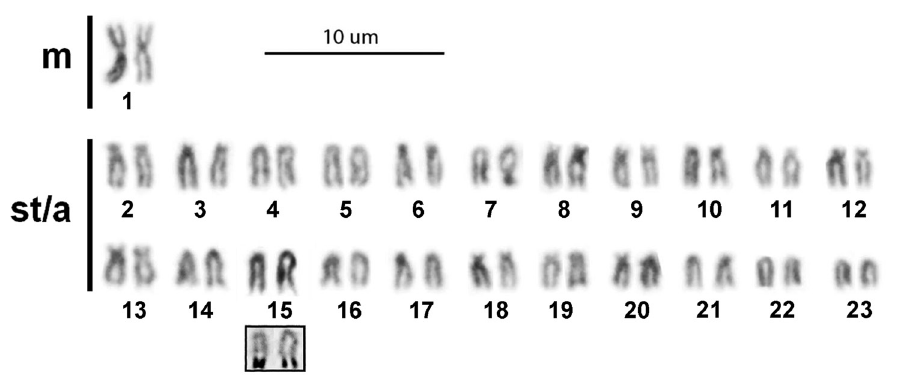
Figure 2. Conventional Giemsa-stained karyotype of the Pacific white mullet. In the inset, the acrocen- tric chromosome pair n. 15 sequentially Ag-stained; m: metacentric chromosomes; st/a: subtelocentric/ acrocentric chromosomes. Scale bar: 10 μm.